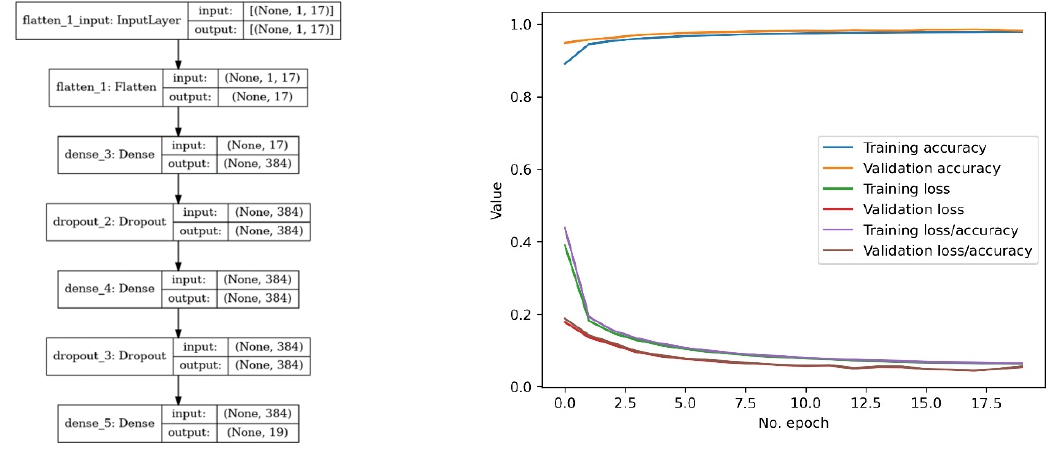
Figure 5. Artificial Neural Network model ( left ) and training loss plot ( right ) generated during the training process.